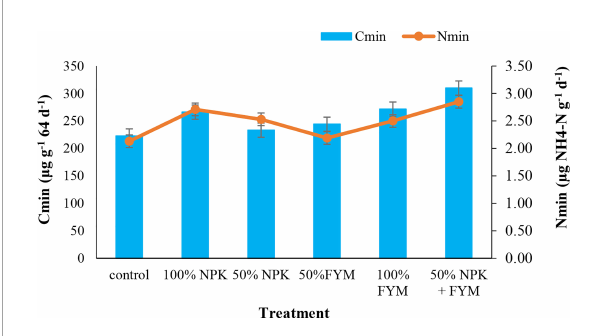
FIGURE 2 Effect of long-term fertilization and manuring on soil mineralizable carbon and mineralizable